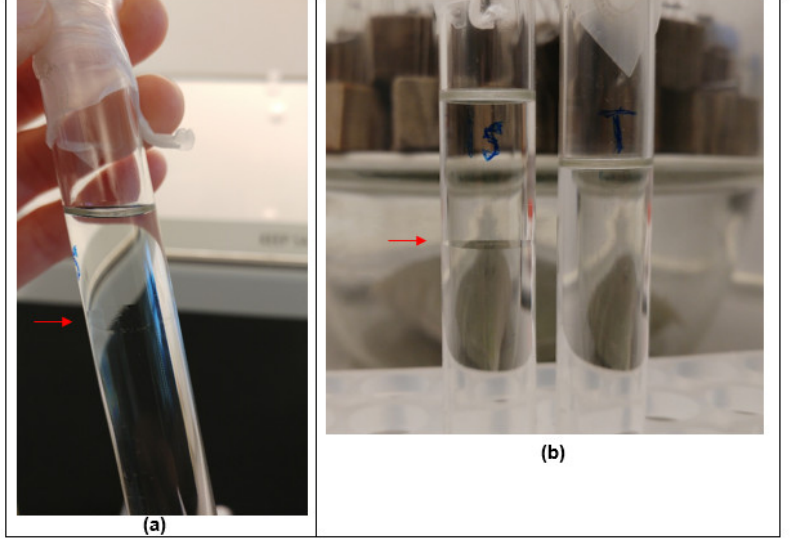
Figure 11. ( a ) PS36000 in isopropanol, showing phase separation of components as indicated by the red arrow. ( b ) = A comparison of PS36000 in isopropanol ( left ) and turpentine ( right ) after one month.